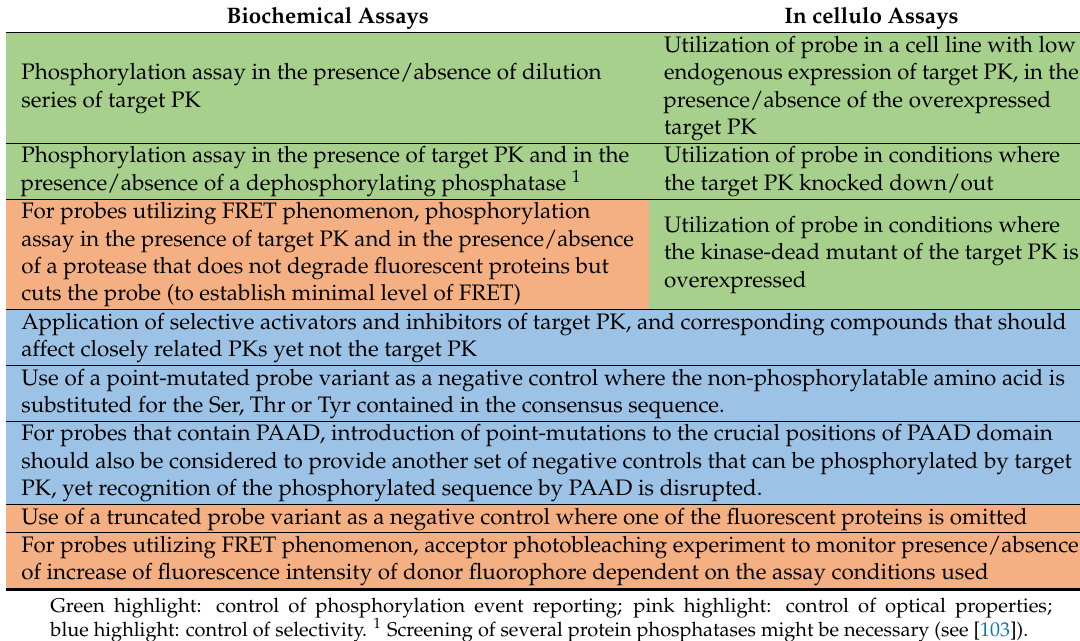
Table 1. Control experiments necessary for characterization of Class 1A